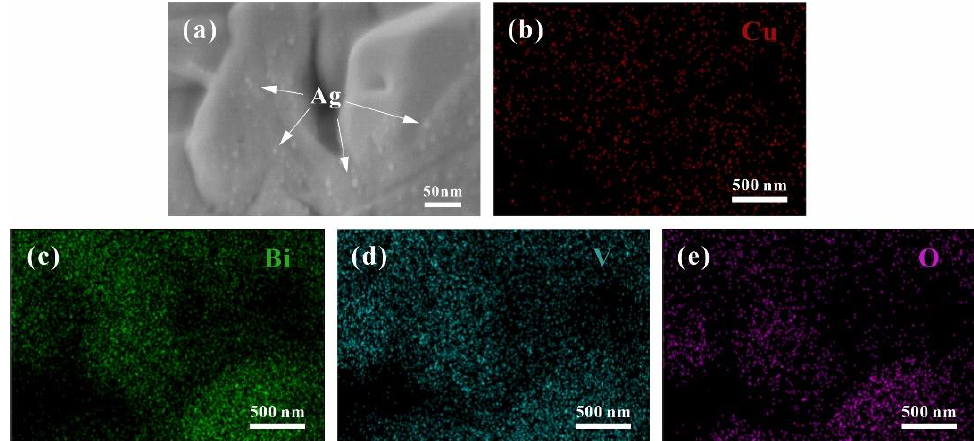
Figure 6. SEM ( a ) and EDS ( b – e ) analyses for: ( a ) Ag/BVO; ( b – e ) Cu/BVO for Cu ( b ), Bi ( c ), V ( d ) and O ( e ).